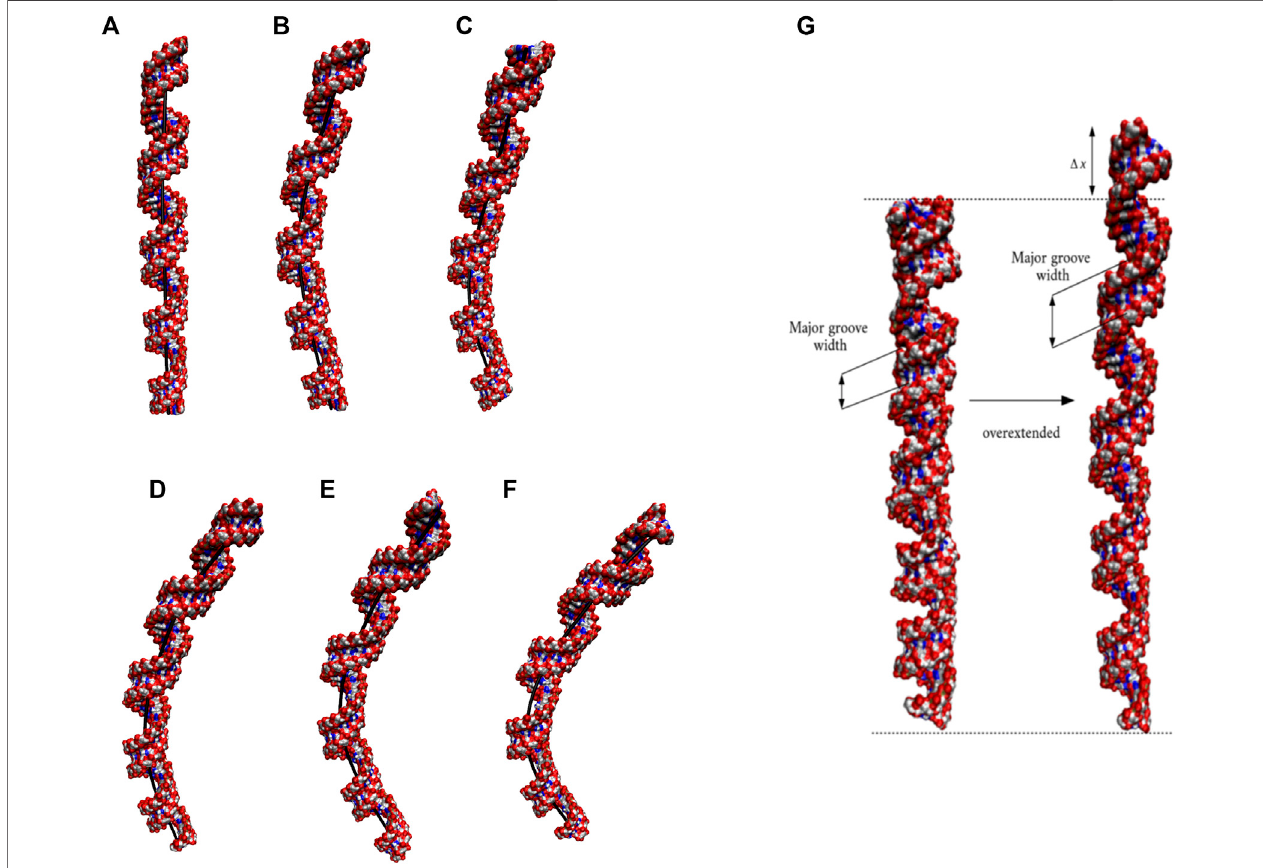
FIGURE 2 | Bending (A – F) and over-extension (G) observed in 20×CUG. Each structure in (A – F) represents different bent states displayed in Table 2 . The curvilinear helical axis is shown as a bold black line to emphasize the curvature in each case. While average rise value in relaxed structure is 2.8 Å, over-extended conformation has average rise value around 3.3 Å due to increase in major groove